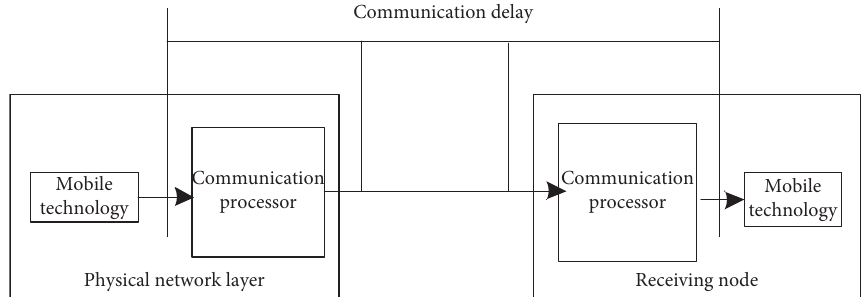
Figure 3: Transmission delay diagram of the mobile network